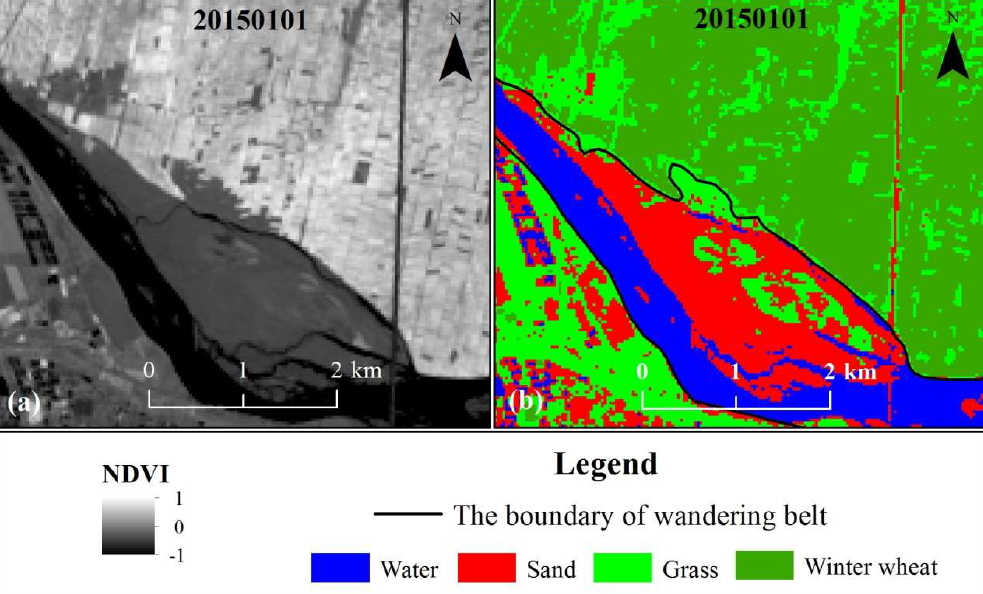
Figure 4. Spatial distribution maps derived from the original Landsat image taken in January 2015 in a small area enlarged for a clearer visual comparison: ( a ) NDVI; and ( b ) different objects including water body, sandy area, grass area, winter wheat area, and the boundary of the wandering belt.